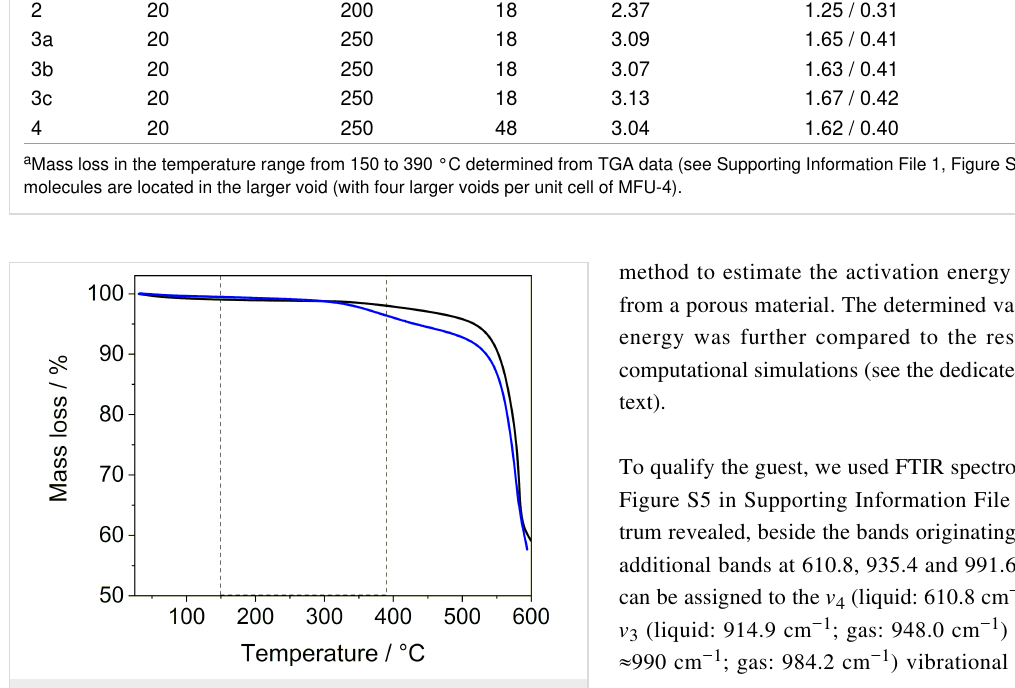
Figure 1: Thermogravimetric analysis of MFU-4 before (black) and after (Sample 3a, blue) the loading of SF 6 measured under a nitrogen atmosphere at a heating rate of 10 K min − 1 .